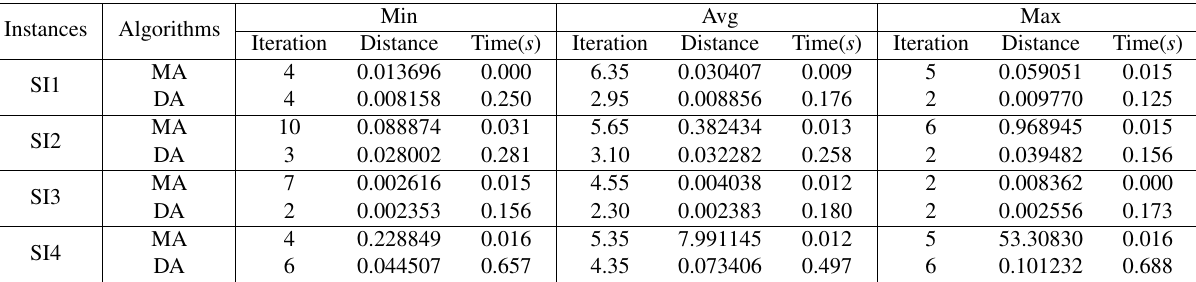
Table 1. The experimental results of the MA and DA